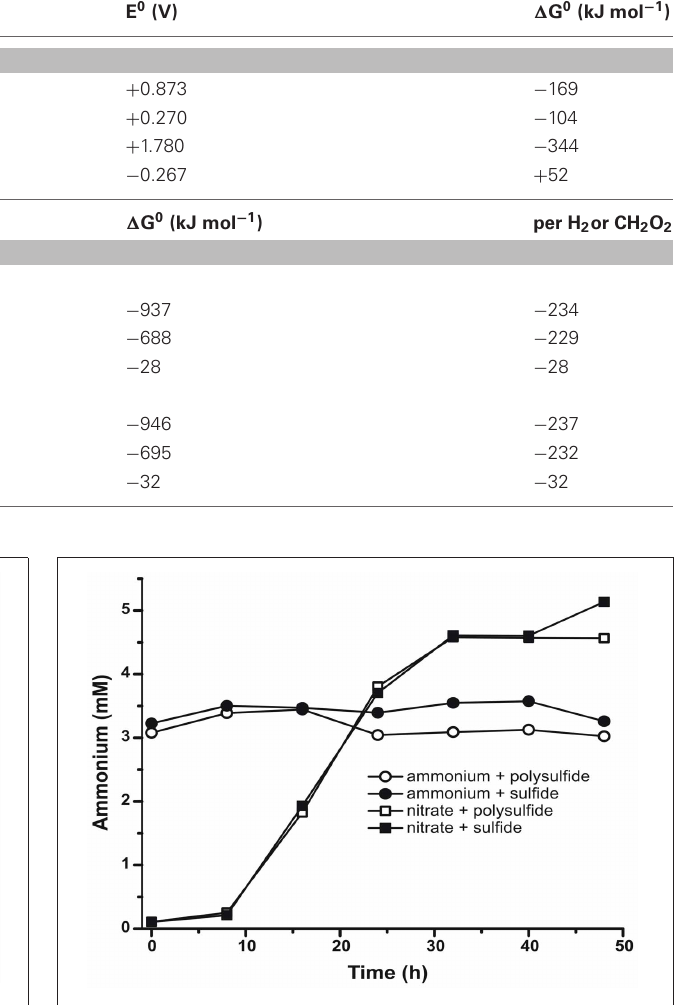
FIGURE 2 | Growth of N. profundicola with indicated electron acceptors, nitrogen compounds, and sulfur sources. Growth rates were determined between 8 and 24 h; k = specific growth rate constant (h − 1 ). Each point is the average of 2 or 3 independent biological replicates.